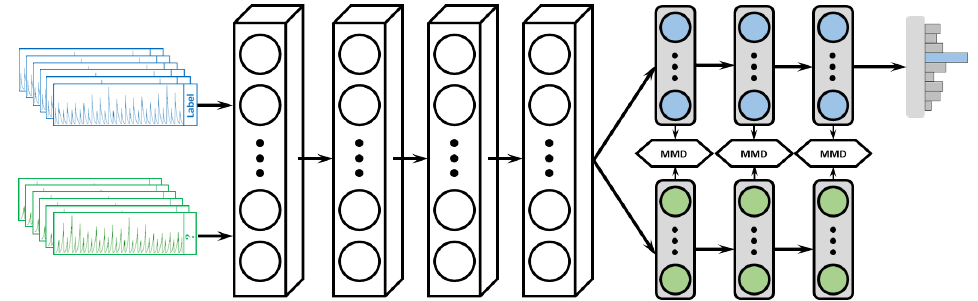
Figure 5: An architecture for cross-device SCA (fine-tuning